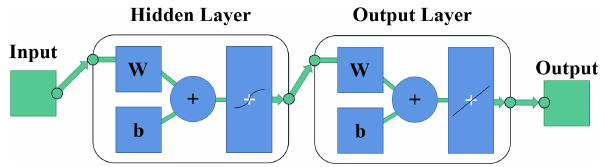
Figure 13. BP neural network model